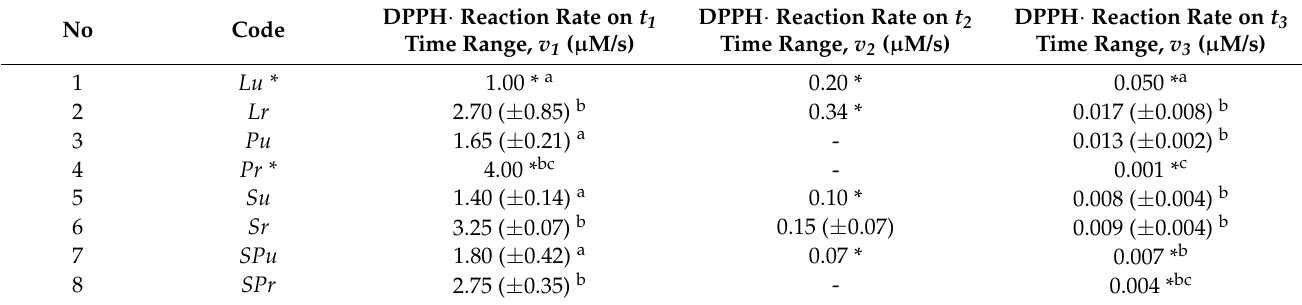
Table 2. DPPH · reaction rates ( v 1–3 — µ M/s, at t 1–3 time ranges: 0–30 s, 30–80 s, and 80–900 s, respectively) for papaya extracts (unripe and ripe, various parts; peel— Lu and Lr , pulp— Pu and Pr , seed— Su and Sr , seed-pulp— SPu and SPr ). Values are expressed as mean ( ± standard deviation, SD), excepting * for single value. For a given parameter ( v 1–3 ), values with different superscript letters are significantly different, according to Fisher LSD (least significant difference) test ( p < 0.05, excepting SPu and SPr cases, with p < 0.10). All p -level values are presented in the Supplementary Material